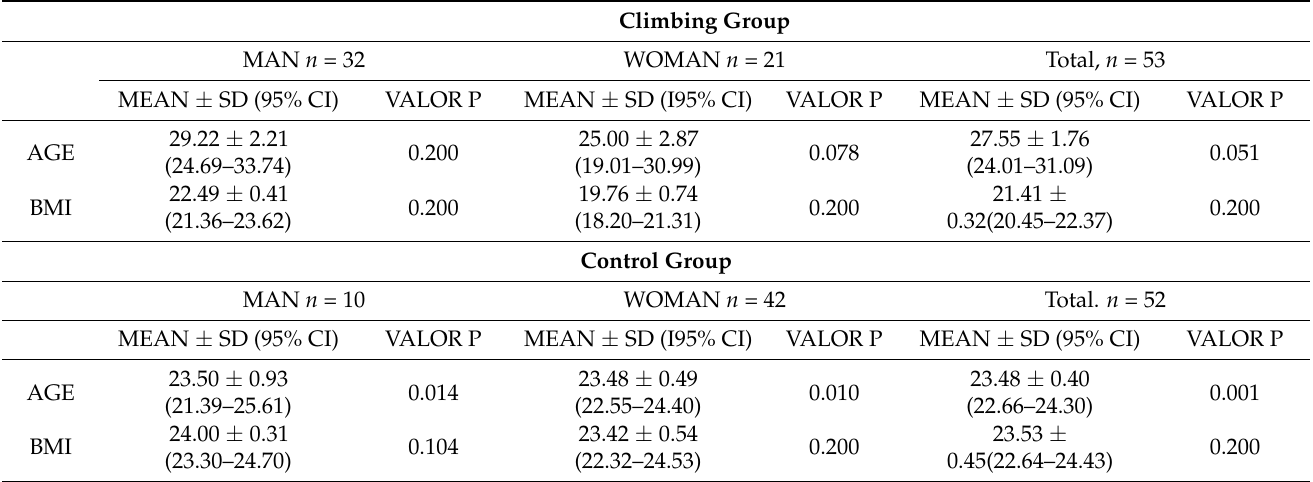
Table 1. Descriptive data of the study participants showing demographic and anthropometric characteristics according to